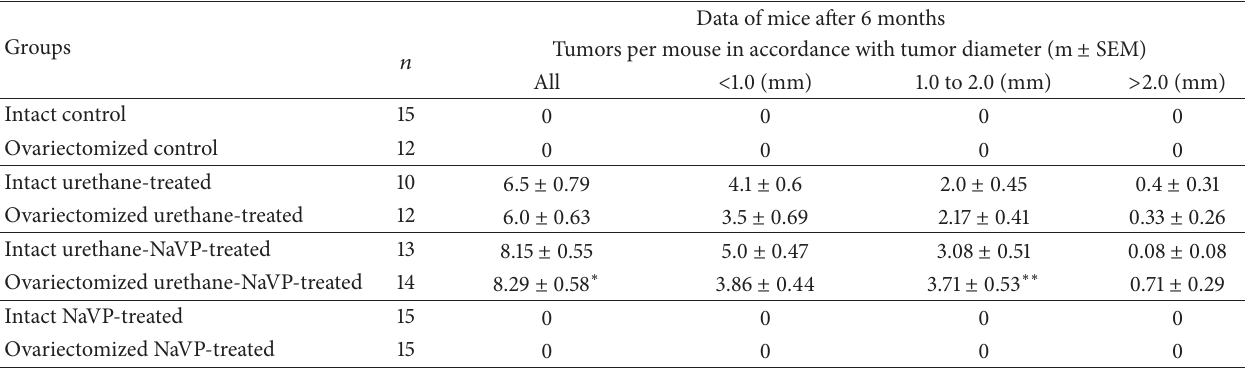
Table 2: Incidence of lung tumors in castrated BALB/c female mice of the study groups in accordance with the tumor diameter.